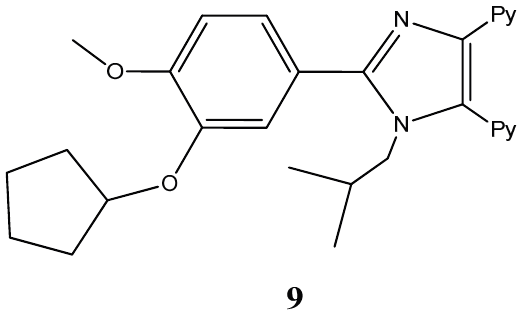
Figure 5. Chemical structure representation of a promising imidazole derivative with proven antiproliferative activity in A549 epithelial cancer cells, by affecting proliferation, migration, anchorage independent growth, and by inducing cycle arrest in the G2/M phase plus the activation of apoptosis